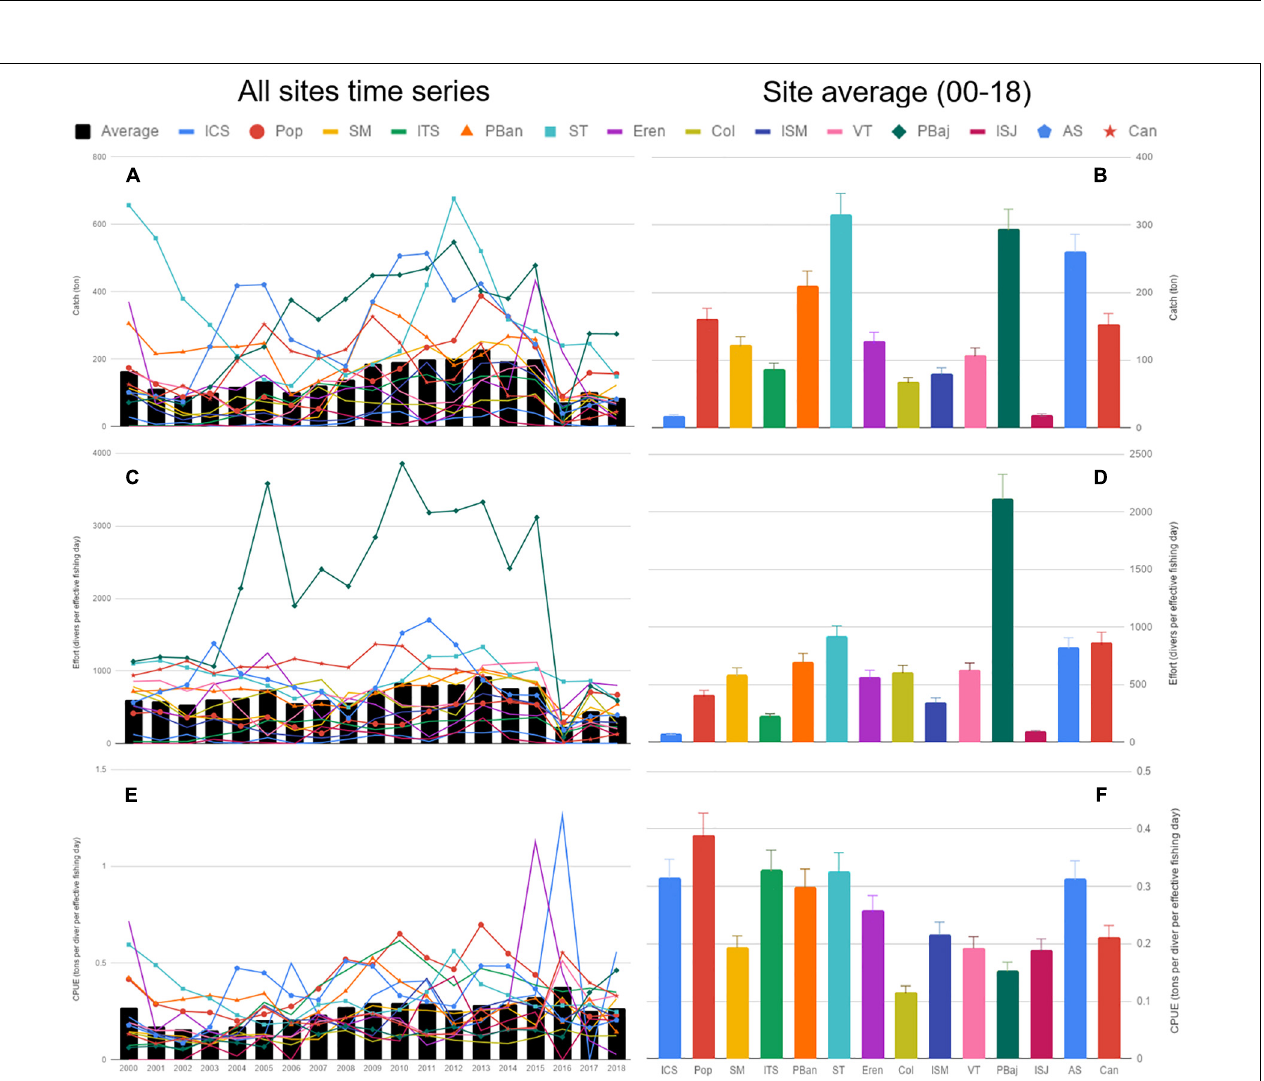
FIGURE 3 | Average catch, effort and CPUE time series (A,C,E) , and the corresponding average per site (B,D,F) . Bars represent SE.